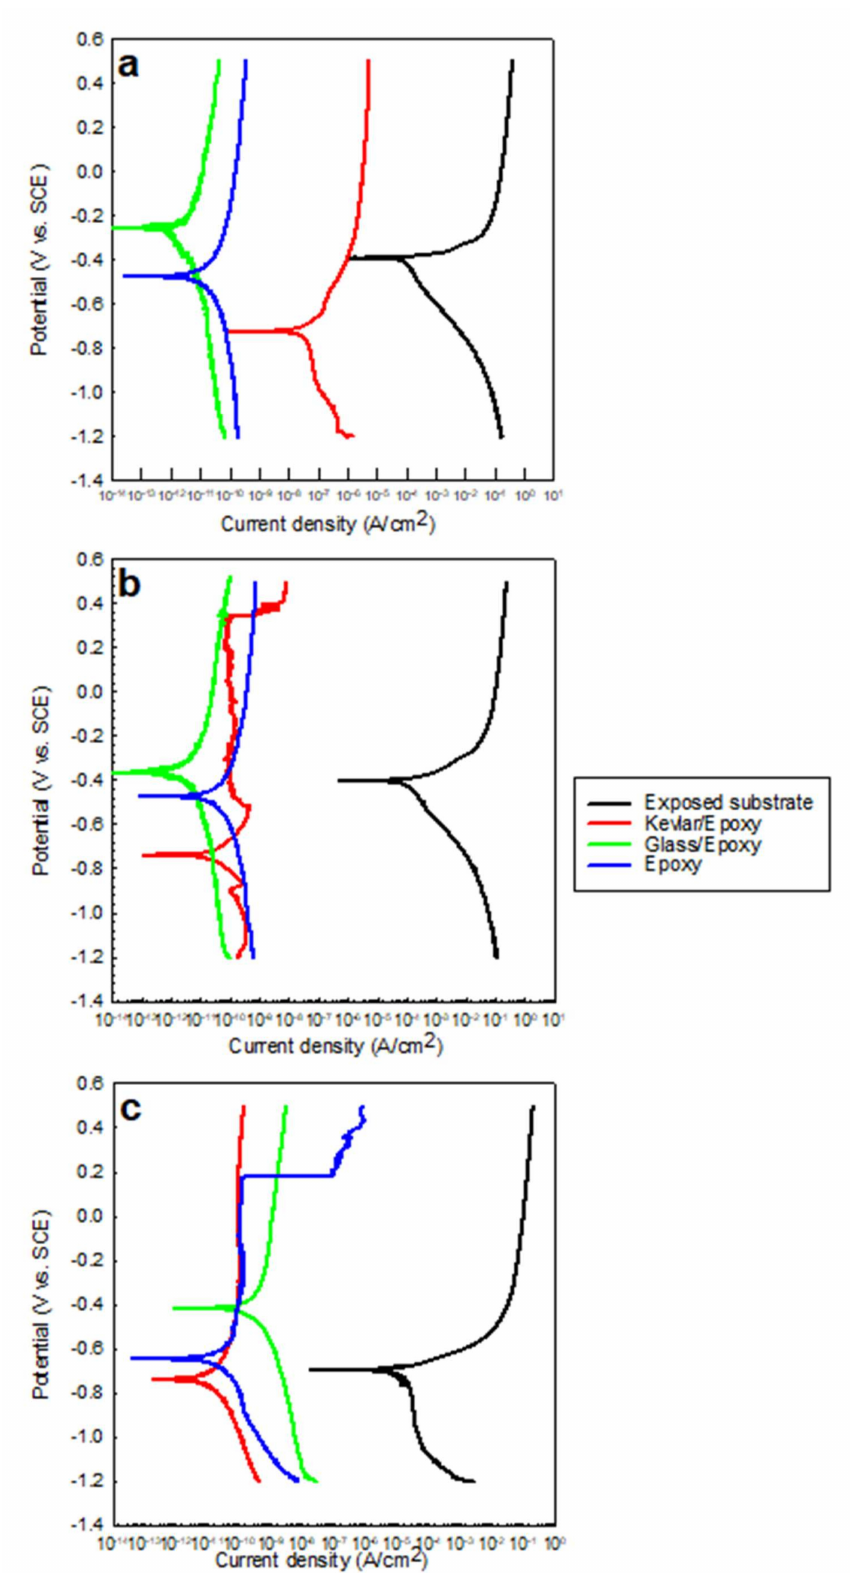
Figure 5. Potentiodynamic polarization in ( a ) 0.5 M NaCl, ( b ) 0.5 M HCl, and ( c ) 0.5 M H 2 SO 4 solutions for the exposed substrate and glass/epoxy, Kevlar/epoxy, and epoxy